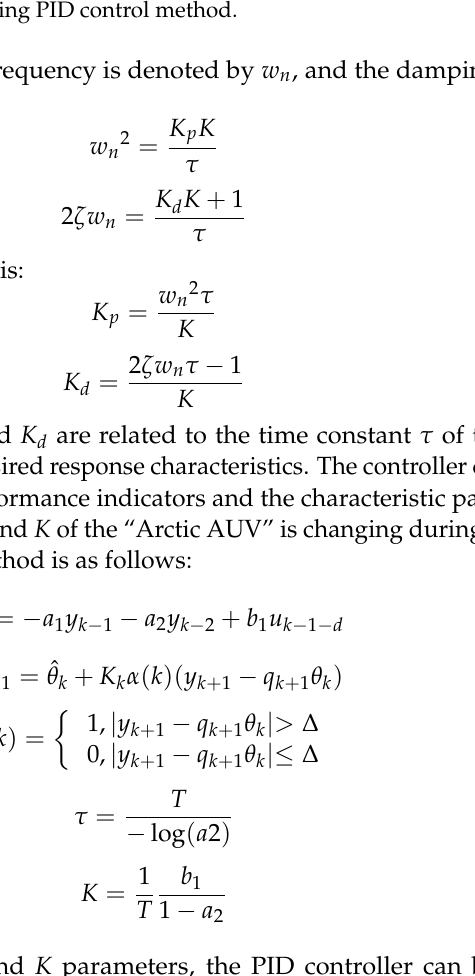
Figure 7. Architecture of self-turning PID control method.